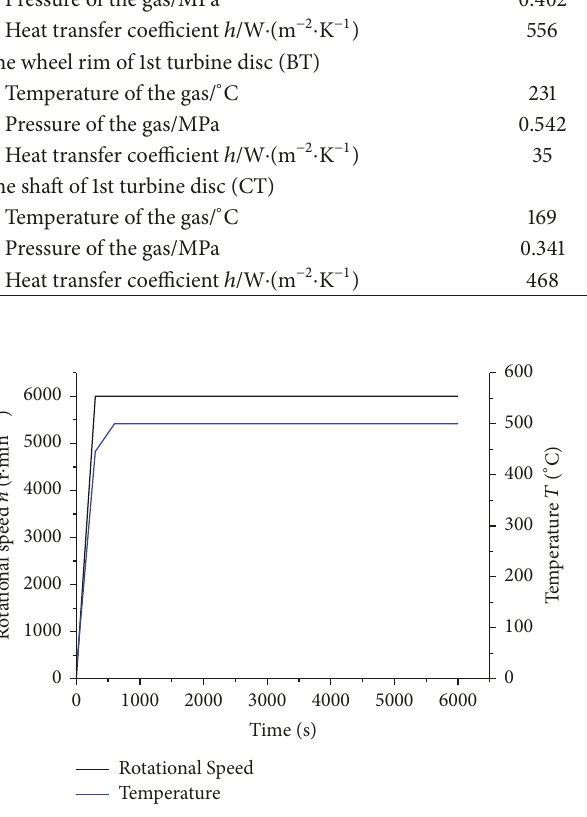
Figure 5: The cold start-up curve of the gas turbine